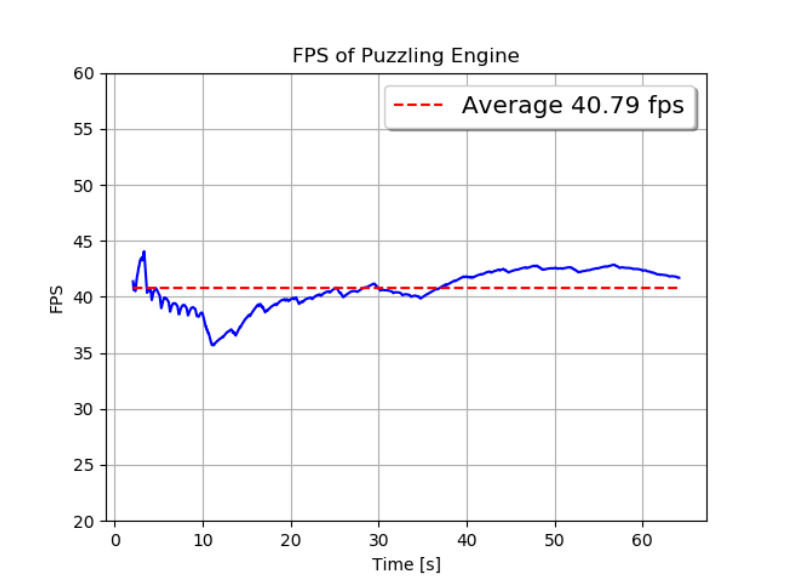
Figure 12. Rendering performance of the Puzzling Engine over a period of time. Actions like loading fragments, displaying matches, and applying transformations are carried out during this